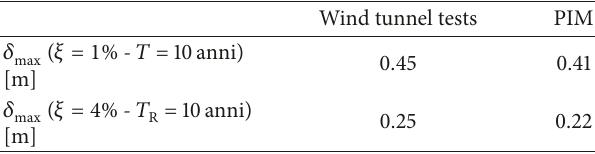
Table 5: Stress design displacements.